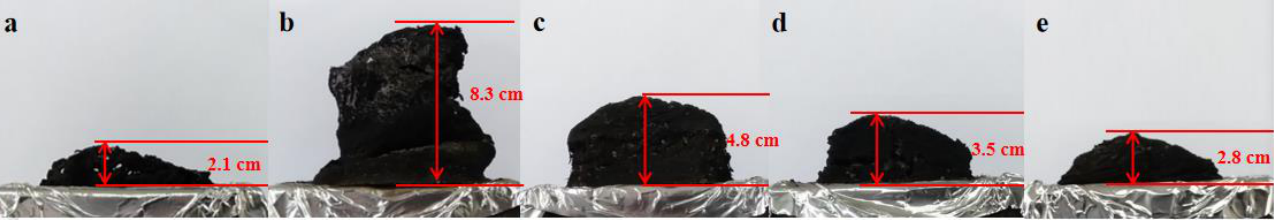
EP/DDS/HPCP − 7/H − U − 2 ( d ), and EP/DDS/HPCP − 6/H − U − 3 ( e ) after cone tests.